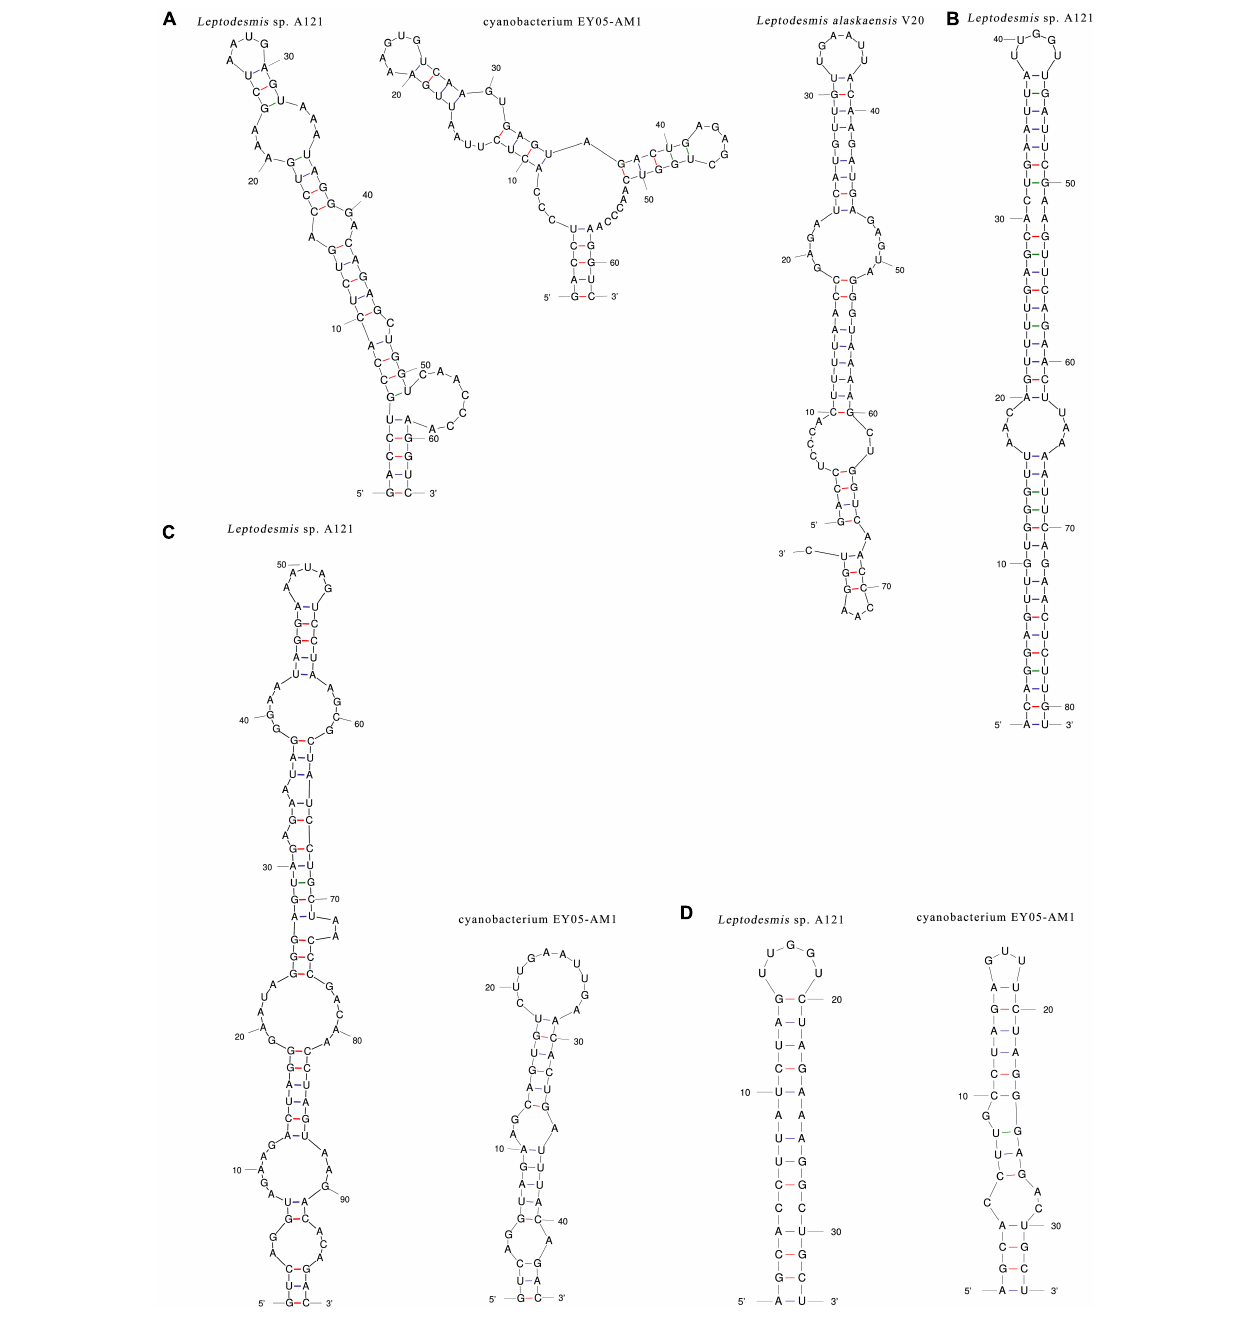
analyses. To summarize, the phylogenomic trees supported the new delineation of Leptodesmis , which was a cryptic genus of Phormidesmis (Raabova et al.,